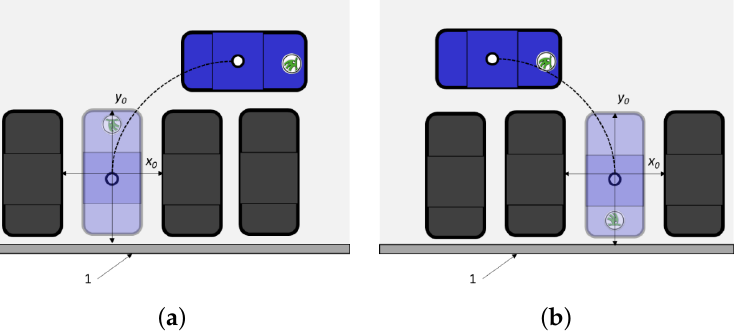
Figure 10. Schematic drawing of perpendicular parking maneuver: 1—curb, x 0 —slot depth, y 0 — slot length. ( a ) Reverse parking. ( b ) Front